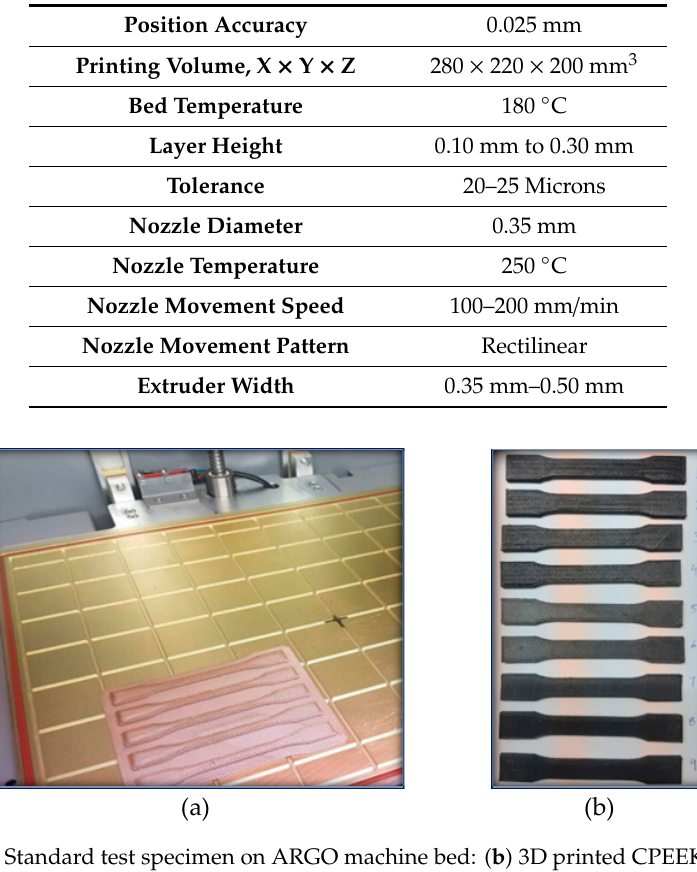
Table 3. Specifications of the fused filament fabrication (FFF) process machine.